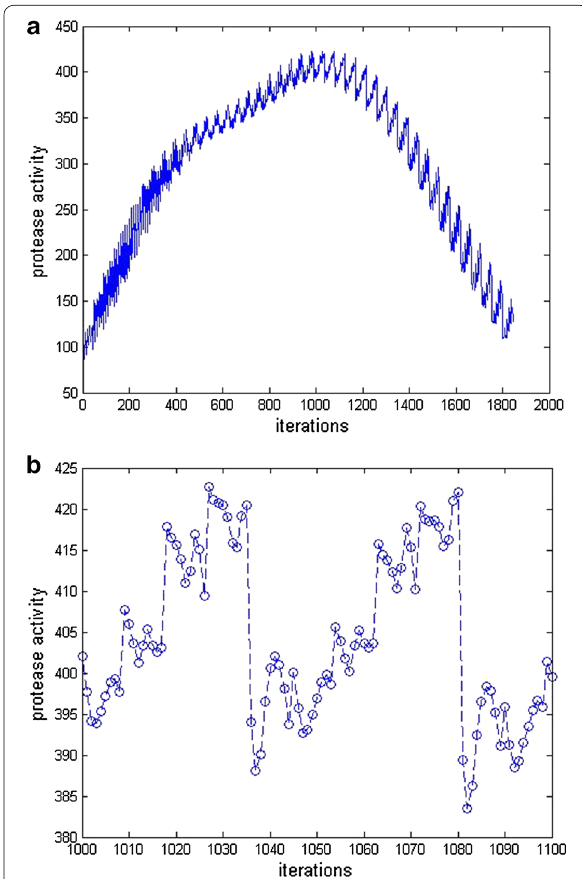
Fig. 2 a Predicted protease activity response of the trained ANN network. b Region of maximum network response